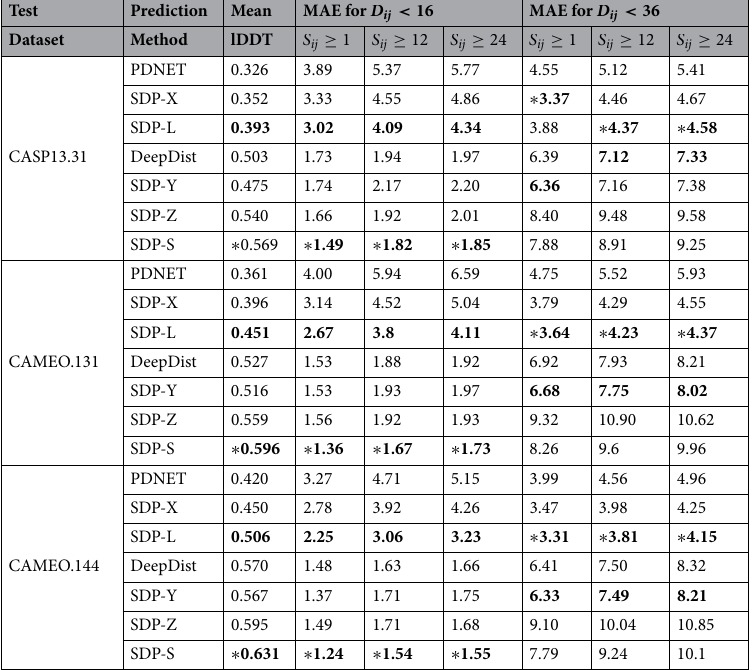
Table 2. Comparison of PDNET, DeepDist, and SDP methods in terms of mean lDDT values over all residue pairs in each dataset. Also, comparison in terms of MAE values for short and long distances and various sequence separation lengths. The column-wise bold values denote the best lDDT or MAE values over the competing methods {PDNET, SDP-X, SDP-L} or {DeepDist, SDP-Y, SDP-Z, SDP-S} for the same dataset. The column-wise starred values denote the best lDDT or MAE values over all the 6 competing methods for the same dataset. For lDDT, the larger the better while for MAE, the smaller the